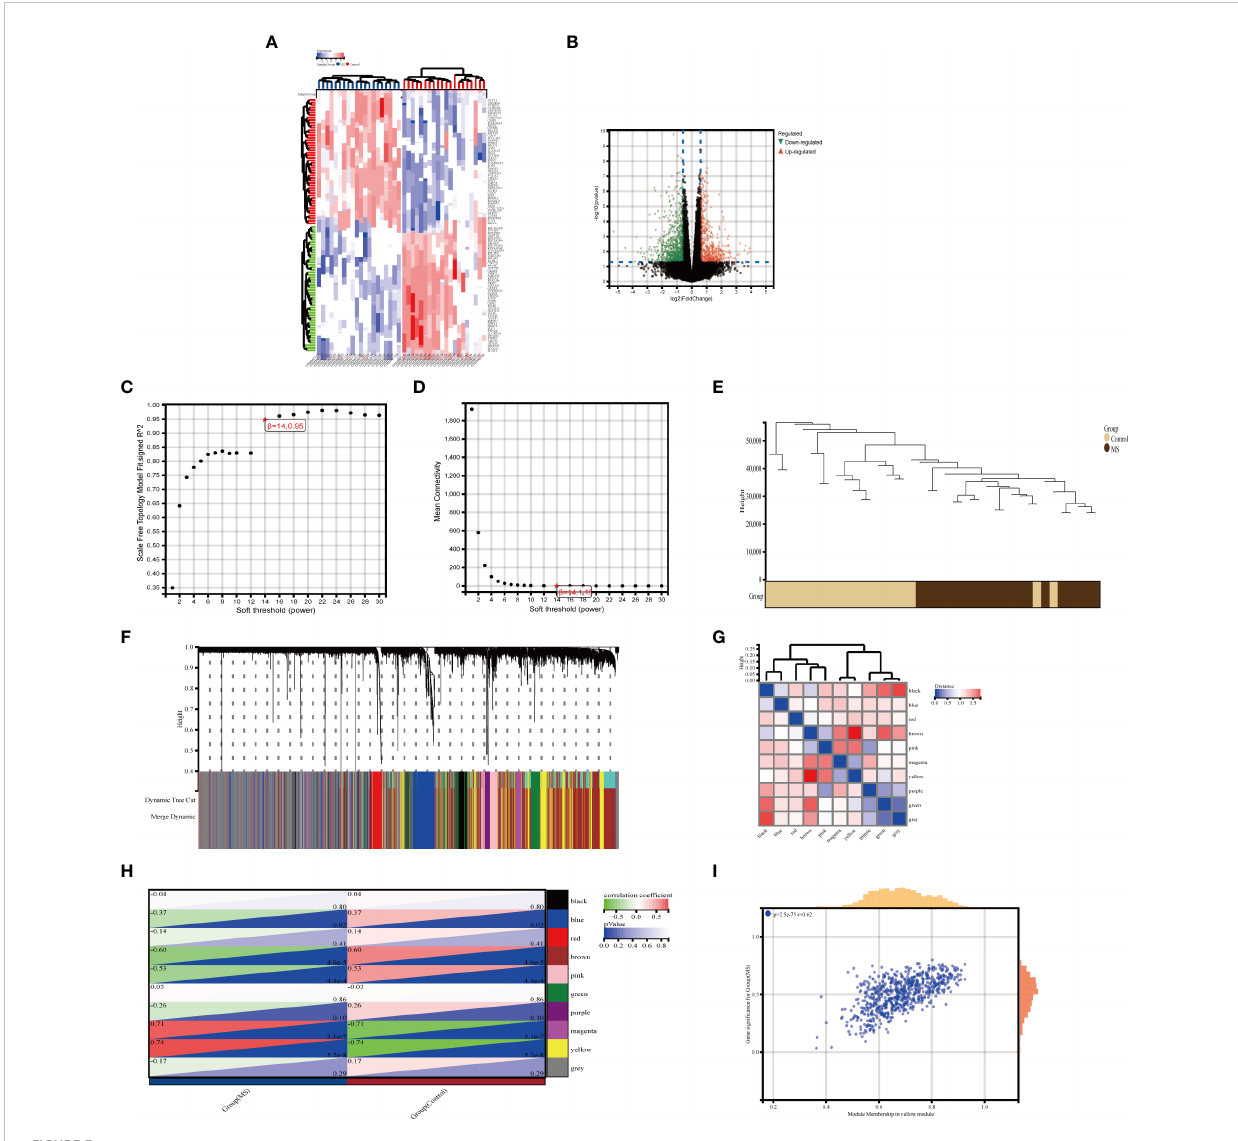
FIGURE 3 Identi fi cation of DEGs via Limma and module genes via WGCNA in MetS. (A) The heatmap displays the top 50 upregulated and downregulated DECs identi fi ed from MetS dataset. Each row represents the intersection of genes, and each column represents one of MetS cases or controls. Red and blue represent upregulated and downregulated ge expression. (B) The volcano plot shows all DEGs, of which red and green triangles refer to signi fi cant DEGs. (C, D) b= 14 is selected as the soft threshold with the combined analysis of scale independence and average connectivity. (E) Clustering dendrogram of the MetS and control samples. (F) Gene co-expression modules represented by different colors under the gene tree (G) Heatmap of eigengene adjacency. (H) Heatmap of the association between modules and Mers. The yellow module is shown to be correlated signi fi cantly with MetS. Numbers at the top and bottom brackets represent the correlation coef fi cient and p-value, respectively. (I) Correlation plot between module membership and gene signi fi cance of genes included in the yellow module WGCNA, weighted gene co-expression network analysis, Limma, linear models for microarray data; DEGs, differentially expressed